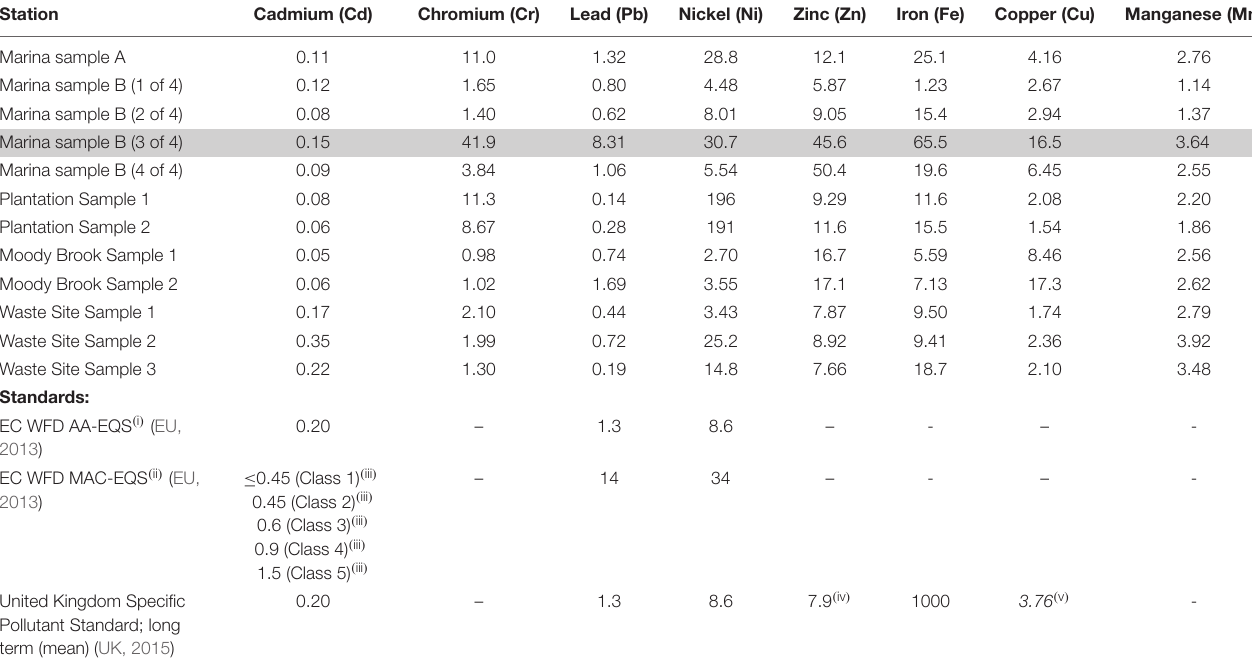
TABLE 4 | Results from metal analysis of samples collected using DGT passive samplers. Station Cadmium (Cd) Chromium (Cr) Lead (Pb) Zinc (Zn) Iron (Fe) Copper (Cu) Manganese